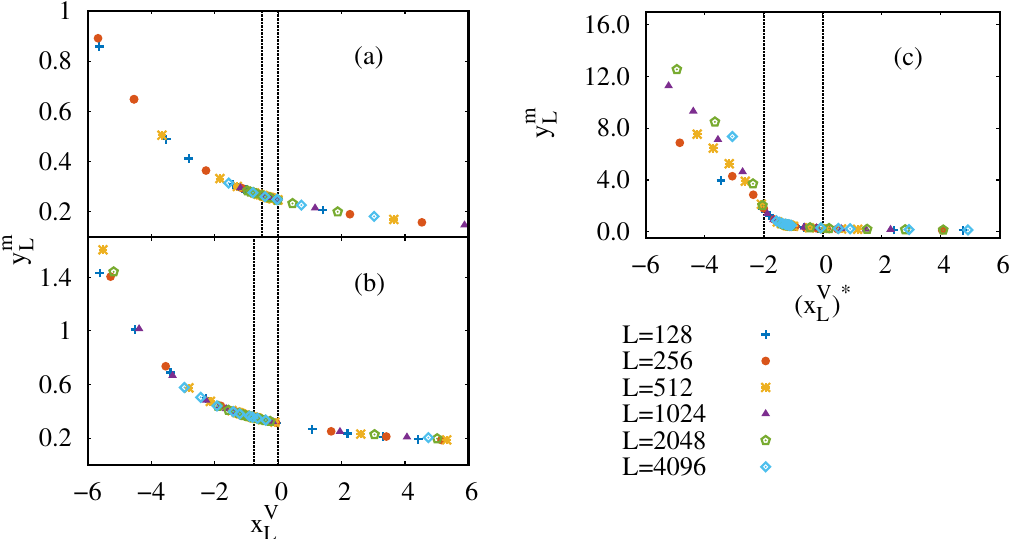
Figure 3: Panel (a): data collapse of the rescaled squared magnetization y m function of the rescaled interaction strength x V panel (a) for α = 1.50. Panel (c): same as panel (b), where the data collapse rescal- ing is performed on the Ka´c-factor-free rescaled interaction (see text). In all panels, the black dashed lines enclose the interval of the independent variable within which the data collapse scaling fit has been